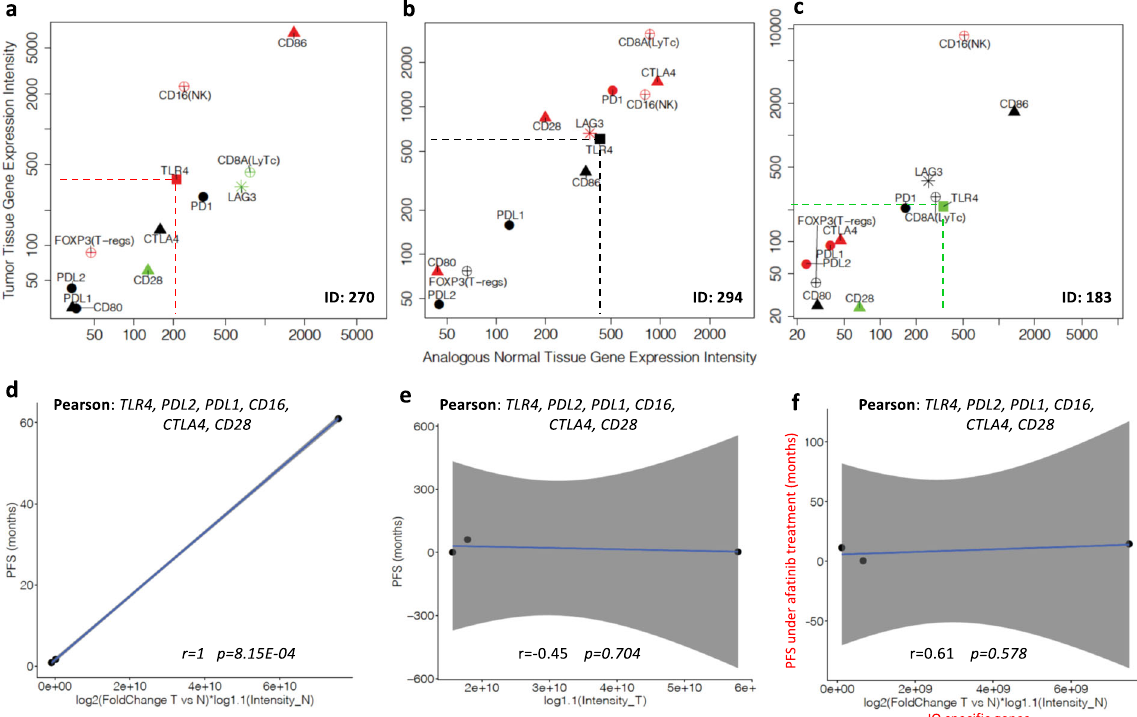
Fig. 3 DDPP intensity plots and correlation with PFS for patients treated with anti-PD-1 therapies. a – c DDPP pro fi les of three patients treated with anti-PDL-1/PD-1 antibodies, with different PFS under treatment. Data source WINTHER trial 11 . a colon cancer: PFS = 0.9 months under treatment with atezolizumab, in fourth therapy line; b head and neck cancer: PFS = 1.7 months under treatment with nivolumab in second therapy line; c colon cancer: PFS = 61 + months under treatment with pembrolizumab, in third therapy line; Y axis: intensity of the expression in tumors; X axis: intensity of the expression in normal matched tissue. d Pearson correlation between a vectorial summation of 6 genes: TLR-4 , PDL-2 , PDL-1 , CD16 (speci fi c marker of NK), CTLA-4, and CD28; X axis: fold value of log2(fold change tumor versus normal) multiplied by intensity in normal values for each of the six genes selected; Y axis: PFS in months. e Pearson correlation between the vectorial summation of the six genes speci fi c anti-PD-1: TLR-4 , PDL-2 , PDL-1 , CD16 (speci fi c marker of NK), CTLA-4, and CD28 , and the PFS of three patients treated with IO when only tumor biopsy information is investigated; X axis: fold value of log2(intensity in tumor) values for each of the six genes selected; Y axis: PFS in months. f Shuf fl e experiment: Pearson correlation between the vectorial summation of the six genes speci fi c anti-PD-1: TLR-4 , PDL-2 , PDL-1 , CD16 (speci fi c marker of NK), CTLA-4 , and CD28 , and the PFS of three patients treated with afatinib; X axis: fold value of log2(fold change tumor versus normal) multiplied by log 1.1(intensity in normal) values for each of the six genes selected; Y axis: PFS of three patients under afatinib treatment normal tissue expression of two genes and their vectorial summation correlated with the PFS of three patients treated with afatinib as monotherapy (Table 1 and Supplemental Fig. 2d – f): NRG4 and NRG2 ( r = − 1 p = 8.4E − 04). The linear regression model is Y = − 4.558e − 02 X + 2.549 (Equation 4), where X = the sum of log2(fold change tumor versus normal) multiplied by log1.1 (Intensity_Tumor) of each value for each of the two genes, and Y = PFS in months. FGFR inhibitors . Nineteen key genes investigated: FGFR1 , FGFR2 , FGFR3 , FGFR4 , and the FGF ligands 1, 2, 3, 4, 5, etc.). The differential expression and vectorial summation of fi ve genes correlated with the PFS of three patients treated with FGFR inhibitors BGJ398 or TAS-120 as monotherapy (Table 1 and Supplemental Fig. 2g – i): FGF10 , FGF16 , FGF5 , FGF2 , and FGF13 ( r = − 1 , p = 3.27E − 03). The linear regression model is Y = − 5.273e − 02 X + 5.135 (Equation 5), where X = the sum of log2(fold change tumor versus normal) multiplied by log1.1 (Intensity_Normal) of each value for each of the fi ve genes, and Y = PFS in months.